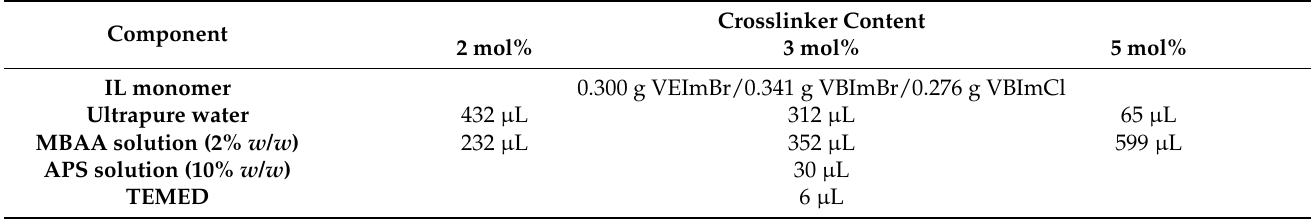
Table 1. Hydrogel composition with different crosslinker contents.